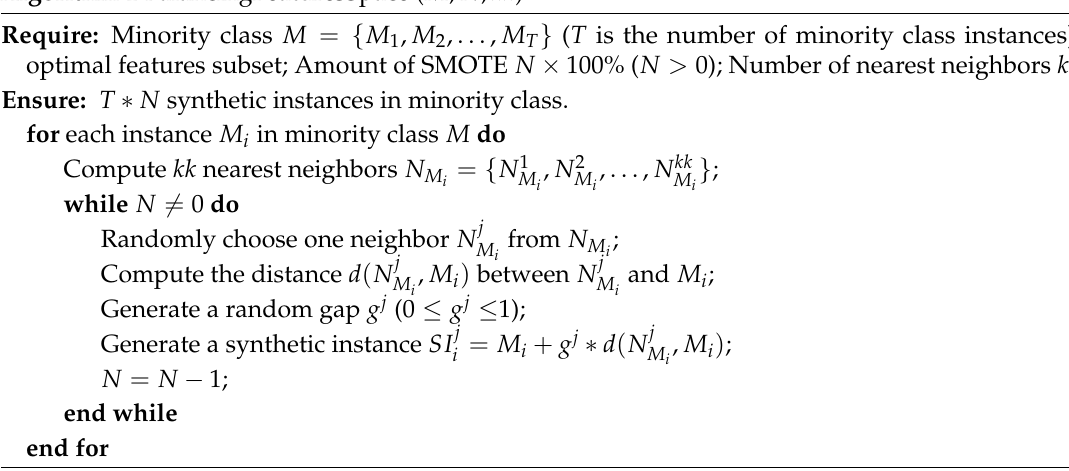
Algorithm 1 BalancingFeaturesSpace ( M , N , kk